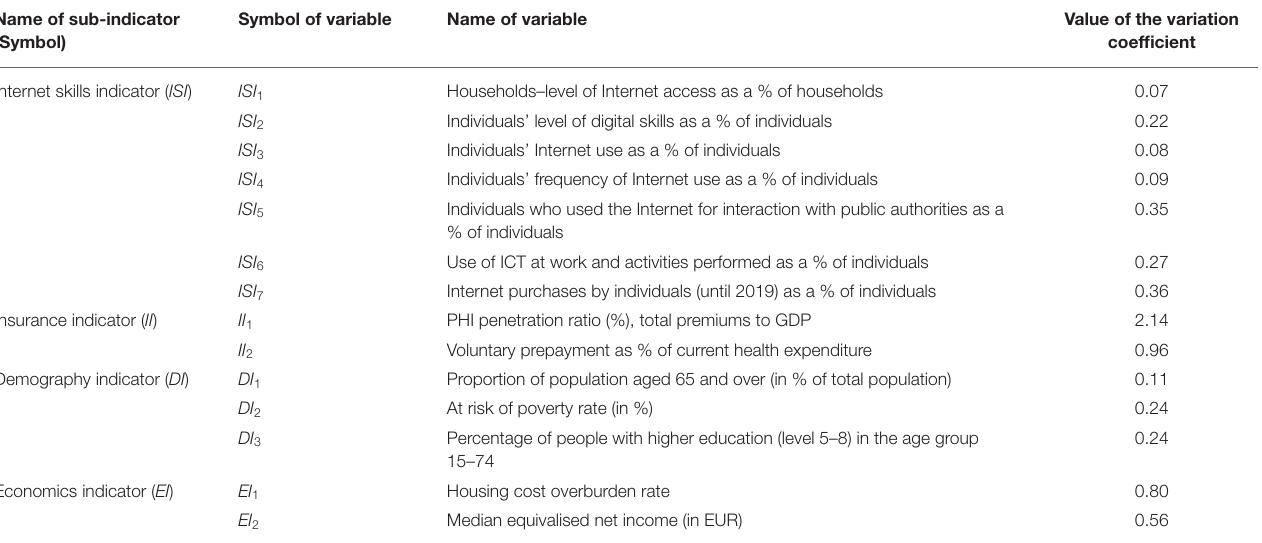
TABLE 1 | Indicators and potential diagnostic